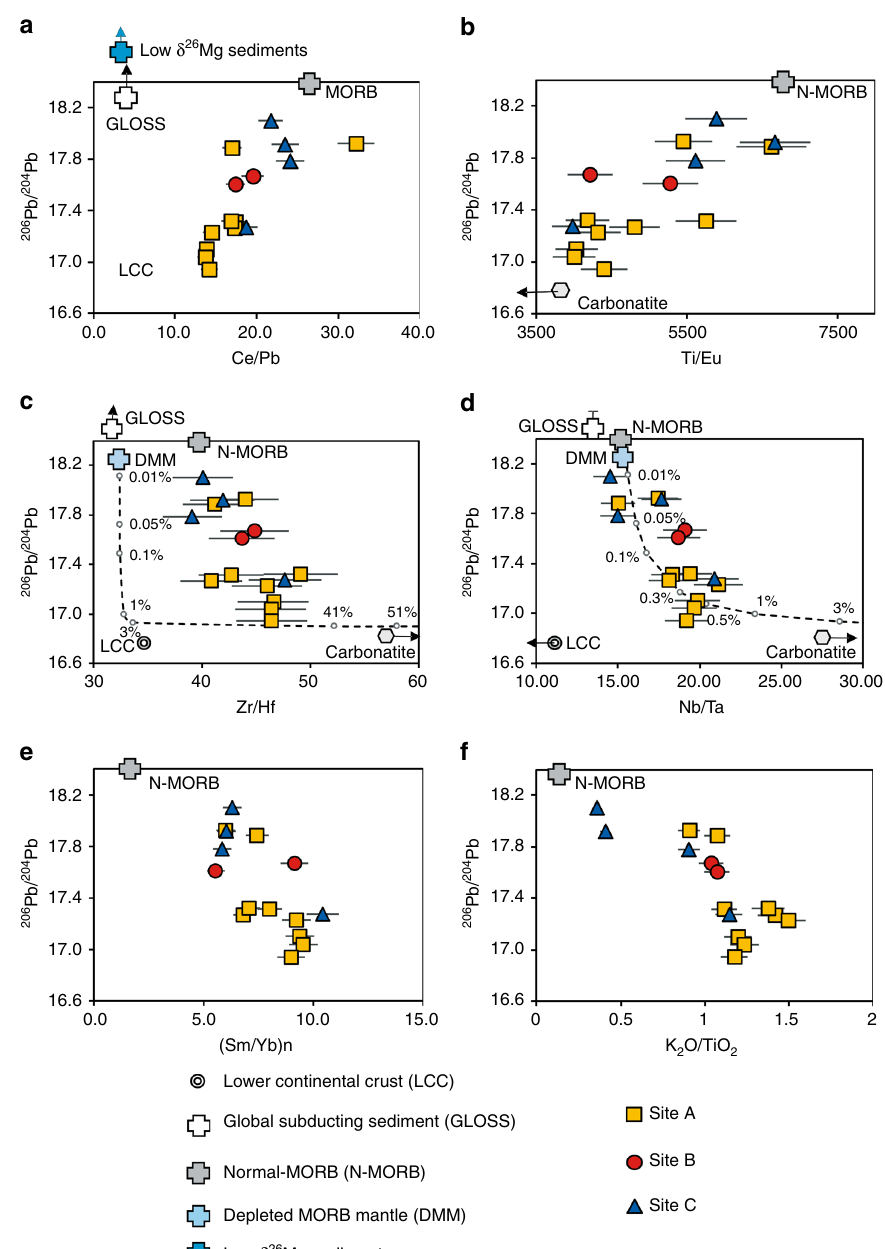
Fig. 2 Diagrams showing correlations between 206 Pb/ 204 Pb and trace and major elemental ratios for petit-spot basalts from the NW Paci fi c plate. a the comparison of measured 206 Pb/ 204 Pb with the Ce/Pb ratio for the basalts from Site A, B, and C. The 2SD of the 206 Pb/ 204 Pb are from 0.002 to 0.02, which are all smaller than the scale of the symbols. The relative uncertainty (2SD) of the Ce/Pb ratio is 7%, which is calculated as and σ Pb are the relative uncertainty for Ce and Pb measurement, both of which is around 5%). The corresponding value of lower continental crust (LCC), global subducting sediments (GLOSS), the low δ 26 Mg marine sediments in the subducting oceanic slab, the normal-MORB (N-MORB), the depleted MORB mantle (DMM), and the carbonatite melt are shown for comparisons (data are from 20,58 – 61 ). b the comparison of measured 206 Pb/ 204 Pb with Ti/Eu ratio. The relative uncertainty (2SD) of the Ti/Eu ratio is 7%. The white hexagon and the dark real arrow shows the composition of the carbonatite, and the data are from ref. 60 . c the comparison of measured 206 Pb/ 204 Pb with Zr/Hf ratio. The relative uncertainty (2SD) of the Zr/Hf ratio is 7%. The dashed curve shows the simulated mixing between the DMM and the carbonatite melt (data for these two endmembers are from ref. 59,60 , and the numbers are the percentage by weight of the carbonatite melt. d the comparison of measured 206 Pb/ 204 Pb with Nb/Ta ratio. The relative uncertainty (2SD) of the Nb/Ta ratio is 7%.The dashed curve shows the simulated mixing between the DMM and the carbonatite melt (data for these two endmembers are from ref. 59,60 , and the numbers are the percentage by weight of the carbonatite melt. e the comparison of 206 Pb/ 204 Pb with primitive mantle normalized Sm/Yb ratio. The relative uncertainty (2SD) of the Sm/Yb ratio is 7%. The primitive mantle composition is from ref. 62 . f the comparison of measured 206 Pb/ 204 Pb with K 2 O/TiO 2 ratio. The relative uncertainty (2SD) of the K 2 O/TiO 2 ratio is